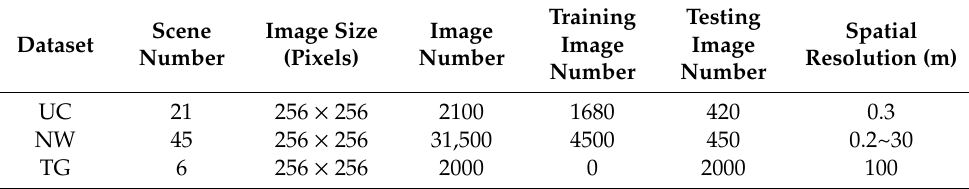
Table 1. Information of experimental data.